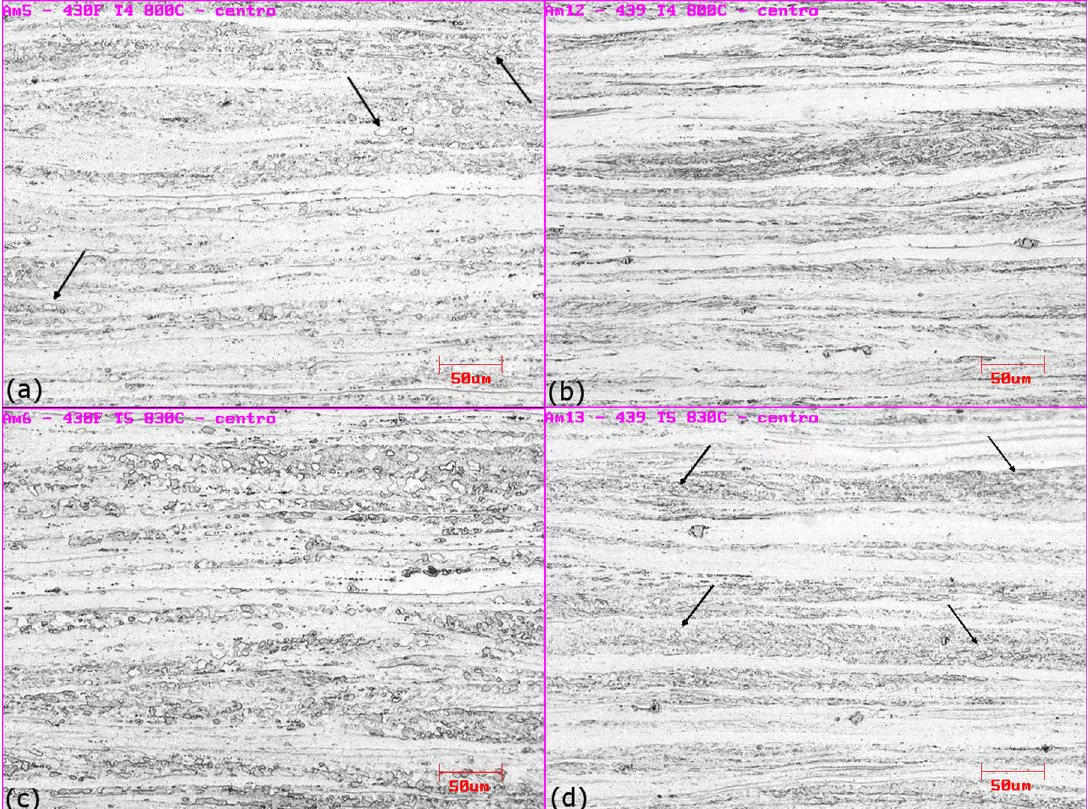
Figure 3. Microstructure of the samples with interrupted annealing treatment at temperatures T4, 800 °C, (a) 430Nb T4 (b) ASTM 439 T4 and T5, 830 °C, (c) 430Nb T5 (d) ASTM 439 T5.